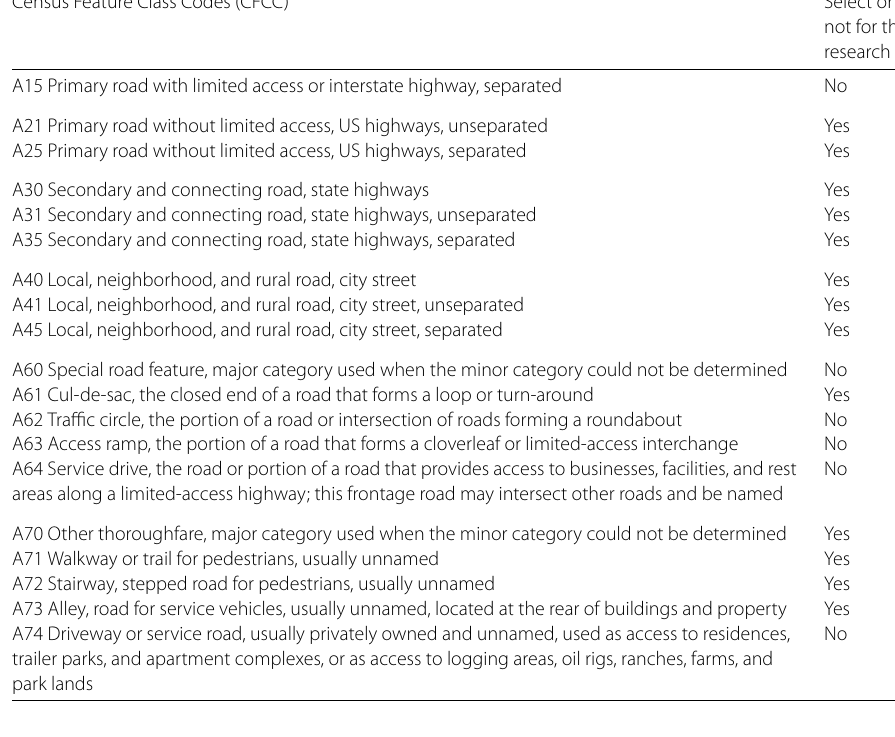
Table 6 Street segment selection based on the Census Feature Class Codes (CFCC) Census Feature Class Codes